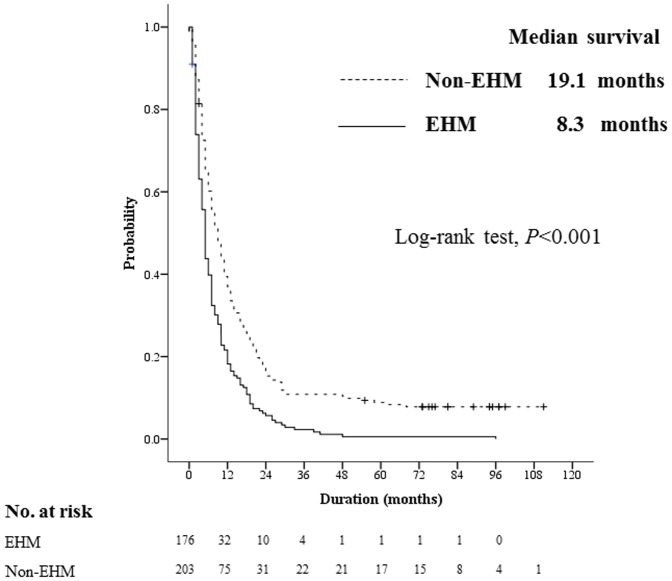
Kaplan-Meier survival curve for the EHM and the non-EHM group.Within the same BCLC stage C, the OS of the EHM group (solid line) was worse than the non-EHM group (dotted line) (median, 8.3 months vs. 19.1 months; P<0.001).